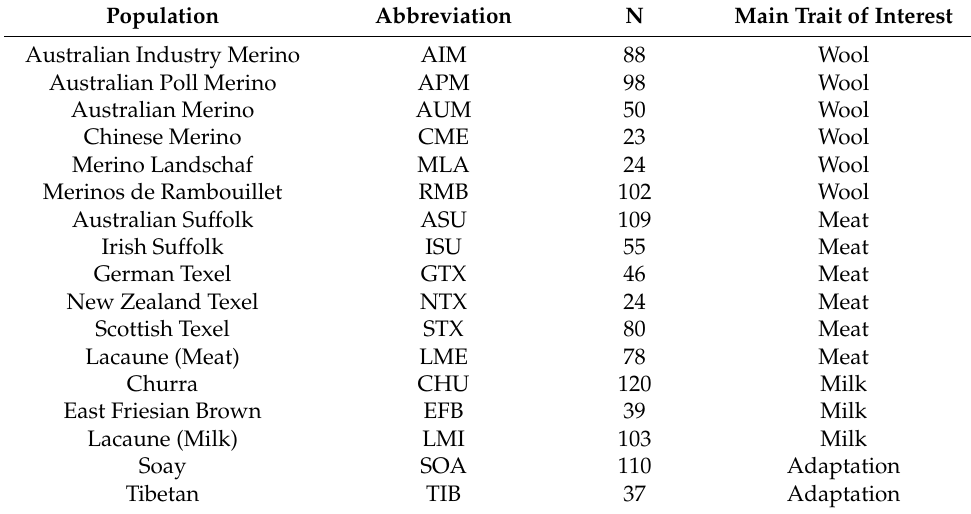
Table 1. Number of samples and traits of interest of worldwide sheep